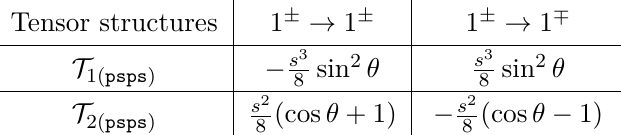
Table 7 . Angular distributions for different psps tensor